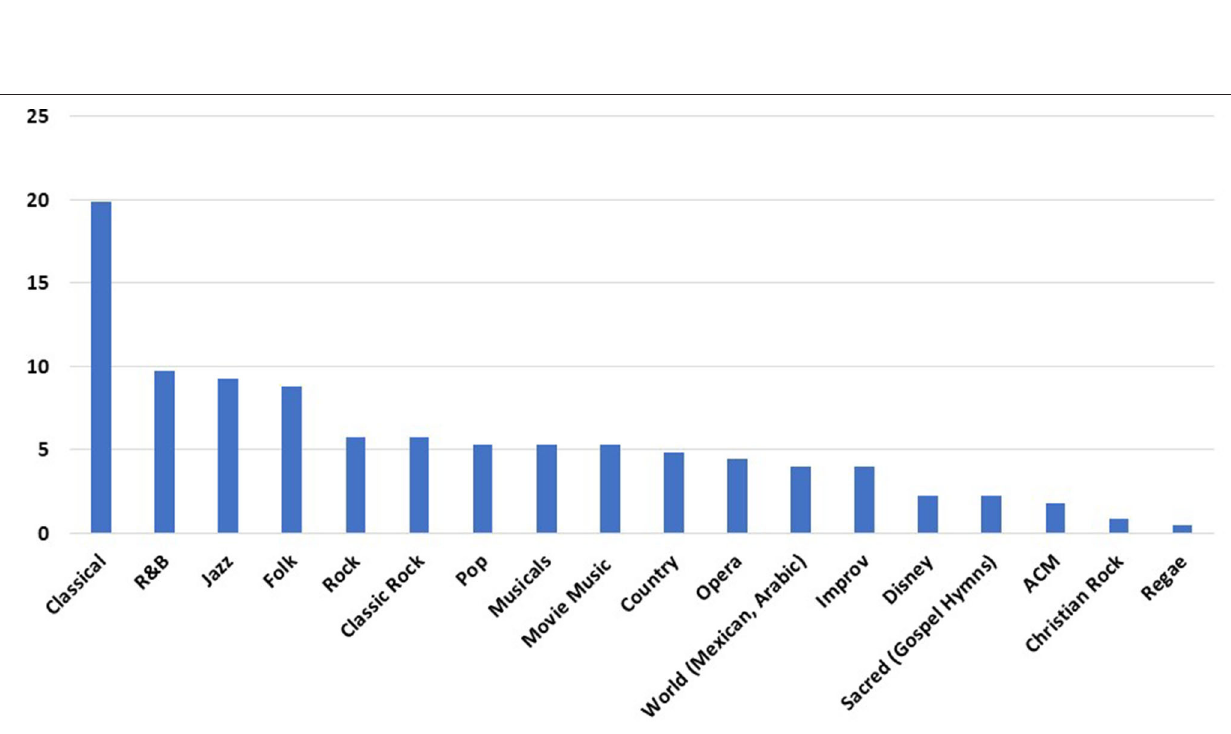
Frontiers in Neurology |